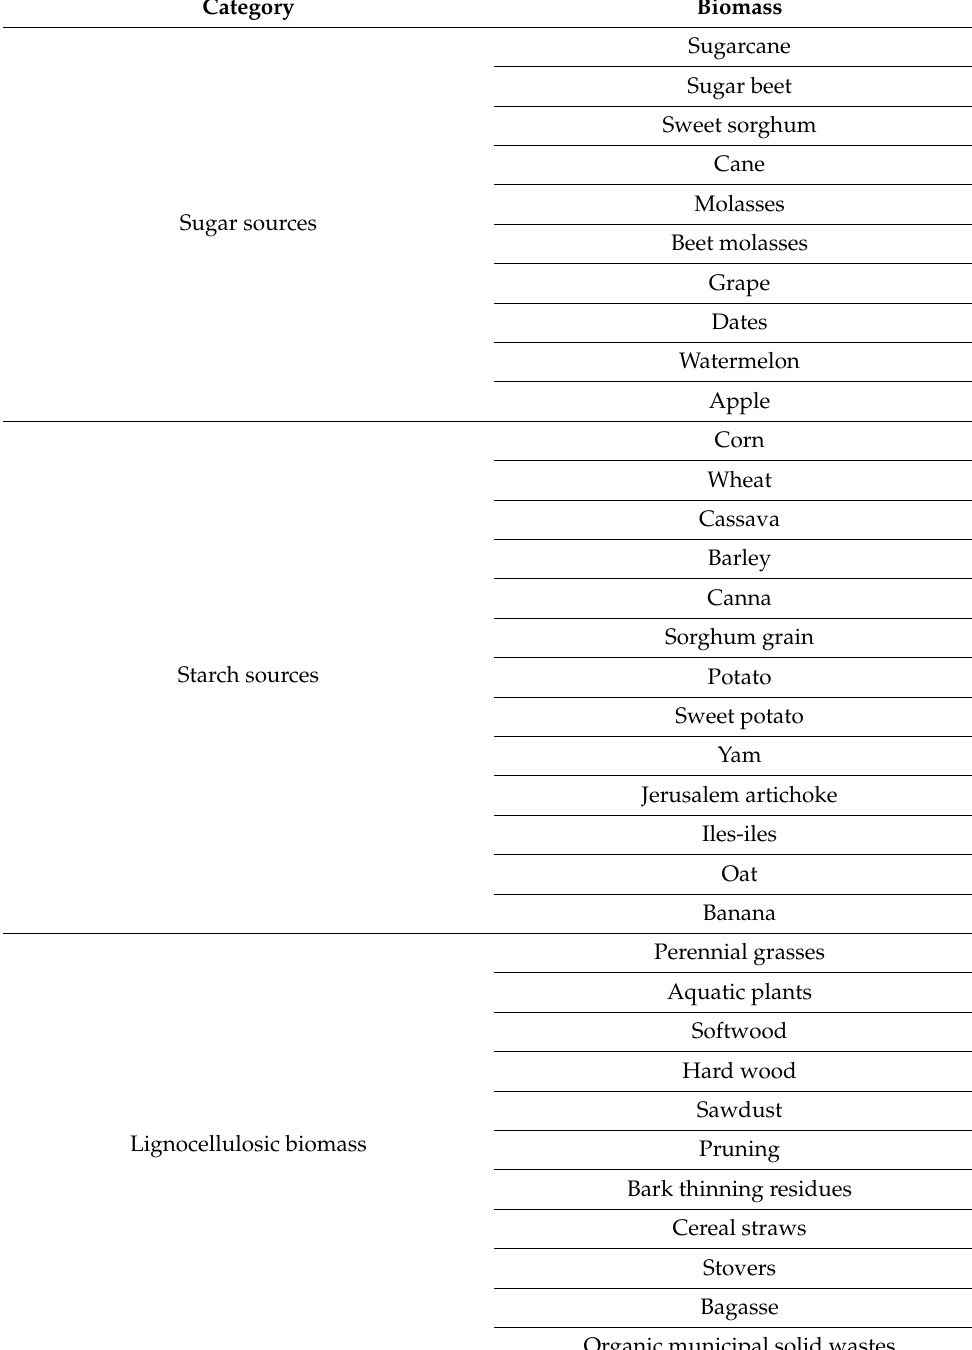
Table 2. Sources of bio-ethanol